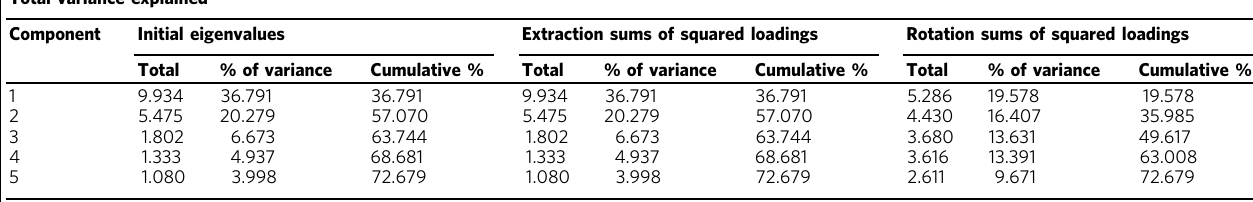
Extraction method: principal components